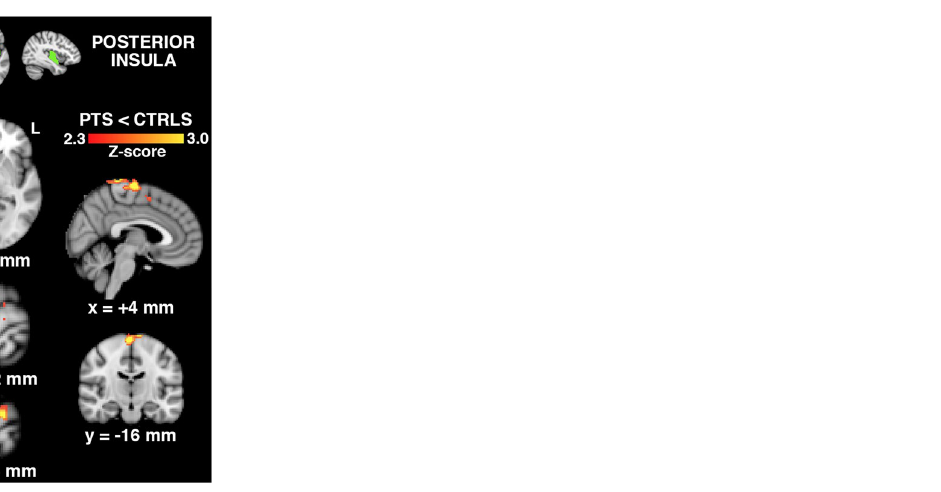
Figure 3. Brain regions (bottom, in red-to-yellow) exhibiting reduced connectivity with the bilateral posterior insula seed region (top, in green) in hip OA patients (n = 30) than in control subjects (n = 10), expressed as a statistical Z-score of the difference. Regions include the right temporal pole and regions of the motor and sensory cortices associated with hip movement and sensation (x,y,z-coordinates of shown brain slices correspond to the MNI brain